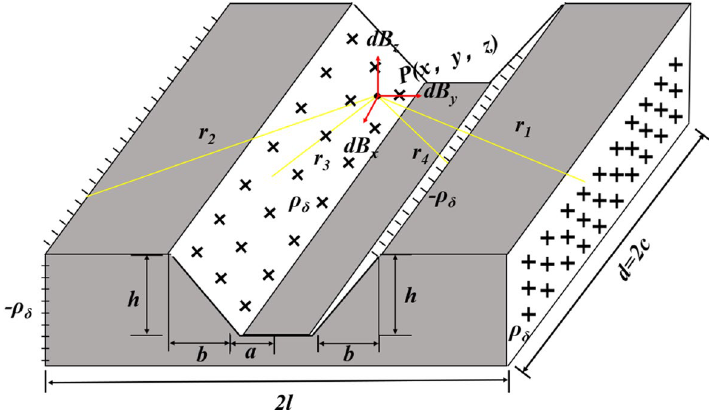
Fig. 1 Three-dimensional magnetic dipole corrosion fault model of trapezoidal groove